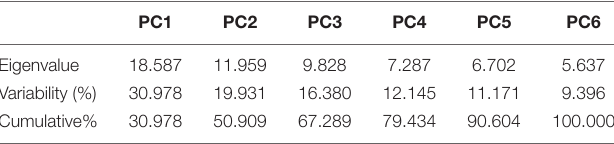
TABLE 19 | Principal component analysis for biochemical traits under control and salt stress conditions in different cotton